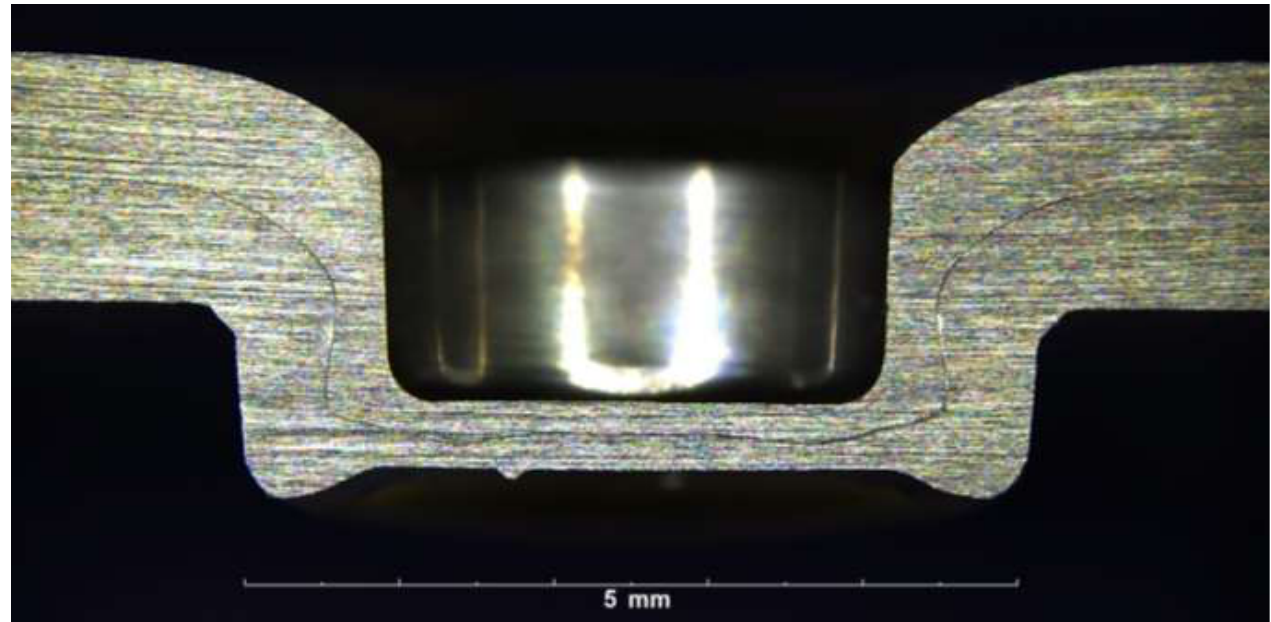
Figure 1. Cross-section of the sheet metal clinching.